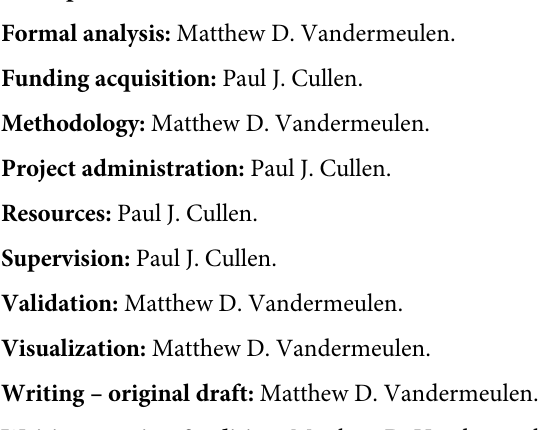
S1 Table. Media used in this study representing diverse environments. S2 Table. References for the cross regulation of pathway components. S3 Table. Yeast strains used in this study. S4 Table. RT-qPCR primers used in this